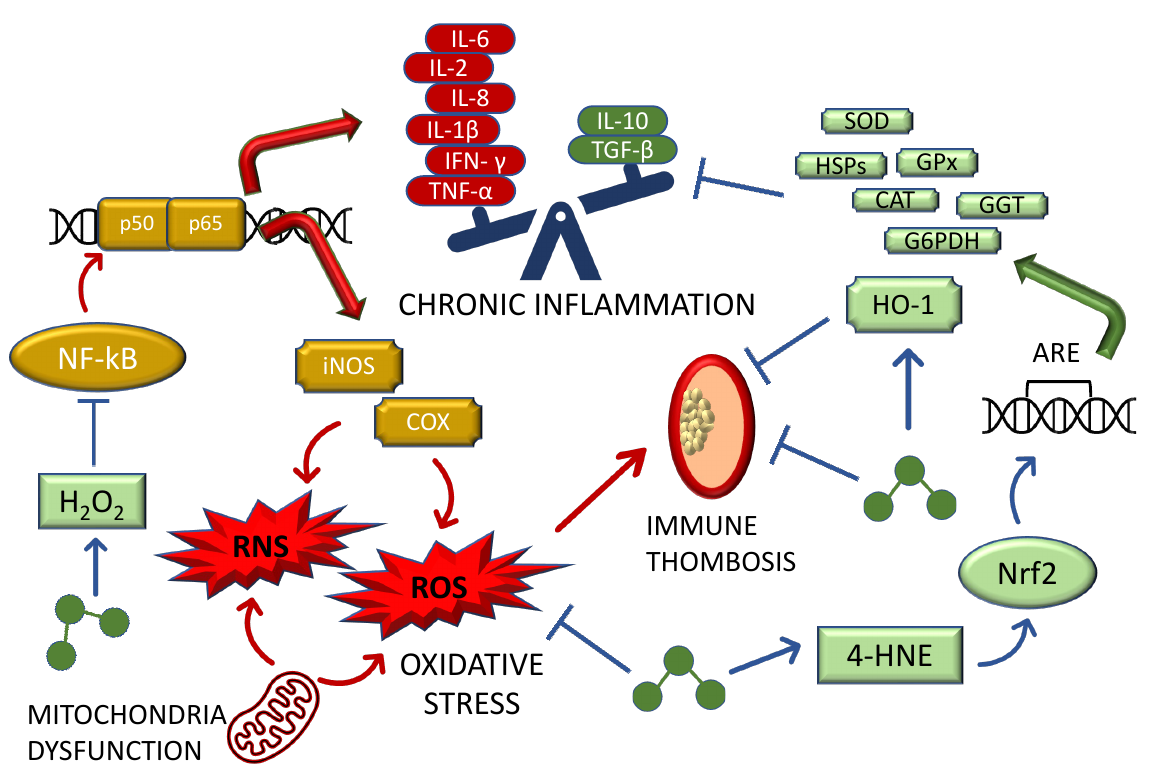
Figure 1. Medical ozone as alternative COVID-19 treatment: molecular insights. Following an in- crease in the expression of NF-kB, a situation of chronic inflammation characterized by an imbalance between pro-inflammatory cytokines and anti-inflammatory molecules is established. Concurrently, NF-kB-mediated signaling triggers the expression of iNOS and COX, which, in turn, promote the accumulation of ROS and RNS. Chronic inflammation and oxidative stress both lead to the forma- tion of immune thrombosis, which are correlated with COVID-19 severity. Medical ozone can act both as an anti-inflammatory molecule (through the H 2 O 2 -mediated NF-kB inhibition) and as an anti-oxidant agent (through the 4-HNE-Nrf2-mediated transcription of various anti-oxidant effec- tors). Finally, the ozone-induced HO-1 elevation counteracts the formation of immune thrombosis. Ozone is represented by the picture with 3 green circles. Abbreviations: ARE: antioxidant